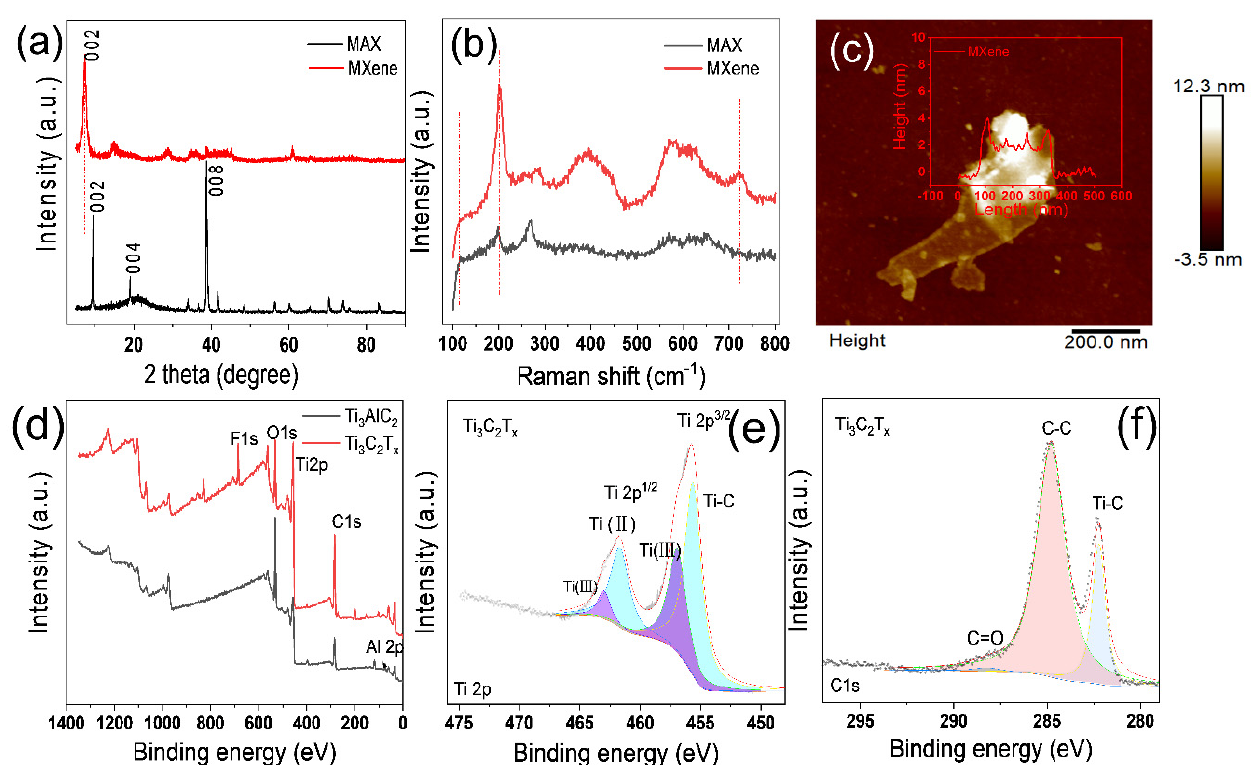
Figure 3. ( a ) A comparison XRD patterns of MAX phase (Ti 3 AlC 2 ) and MXene (Ti 3 C 2 T x ). ( b ) A comparison Raman spectra of MAX phase and MXene. ( c ) MXene photos from AFM microscope. ( d ) XPS spectrum of MAX phase and MXene. ( e , f ) XPS spectrum of Ti 2p, C1s of MXene.